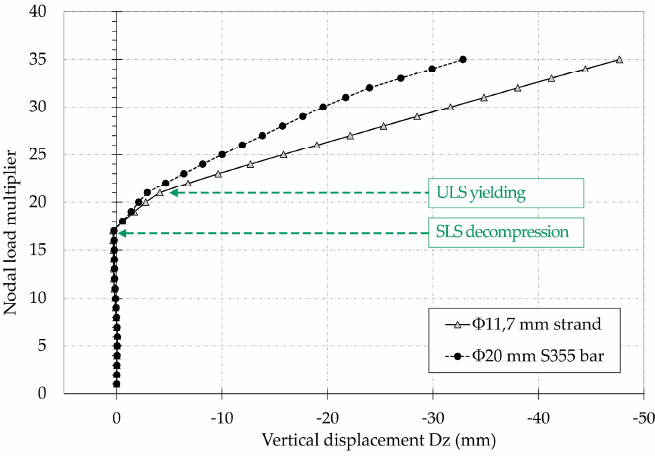
Figure 12. Comparison between the TVT γ -bis beams with pre-stressed bars and pre-stressed strands: load multiplier vs midspan deflection. Buildings 2017 , 7 , 50